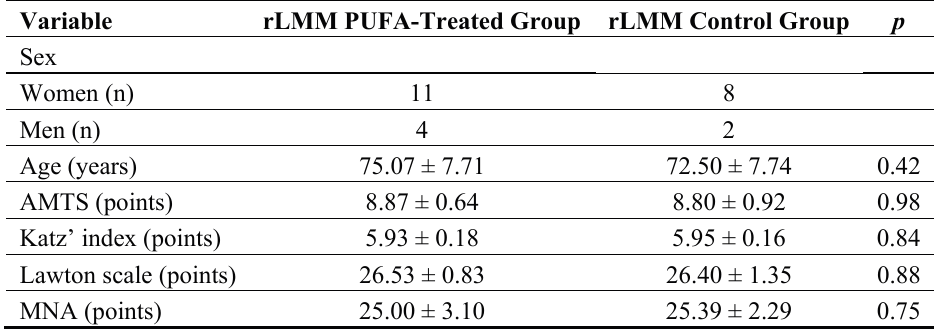
Table 3. The characteristics of studied subjects with risk of low muscle mass (rLMM) only.